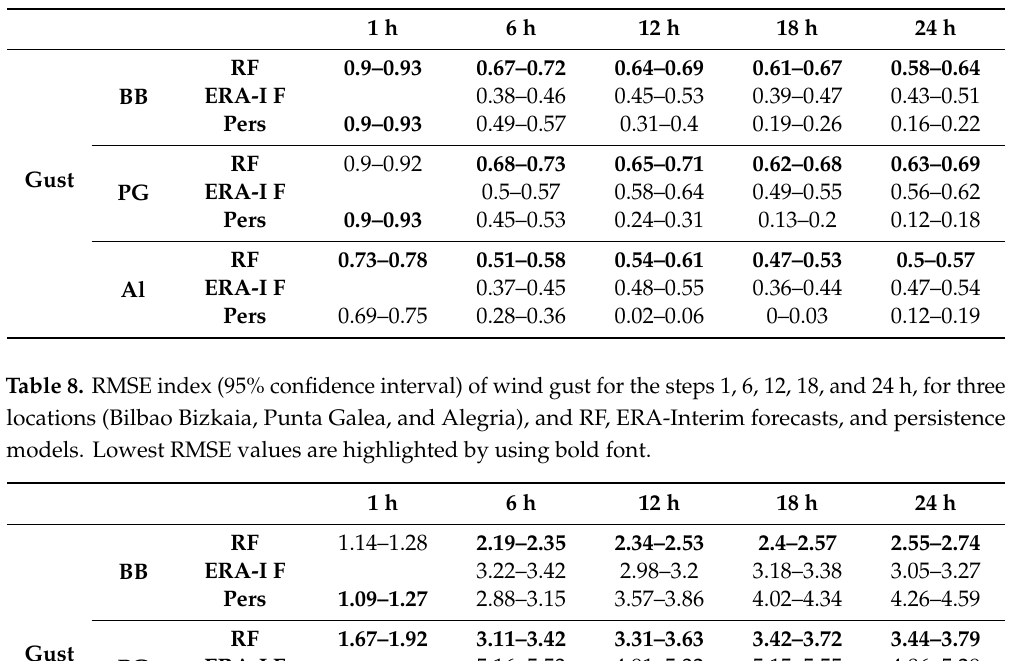
Table 7. R 2 index (95% confidence interval) of wind gust for the steps 1, 6, 12, 18, and 24 h, for three locations (Bilbao Bizkaia, Punta Galea, and Alegria), and RF, ERA-Interim forecasts, and persistence models. The results corresponding to the best model are highlighted using bold font.